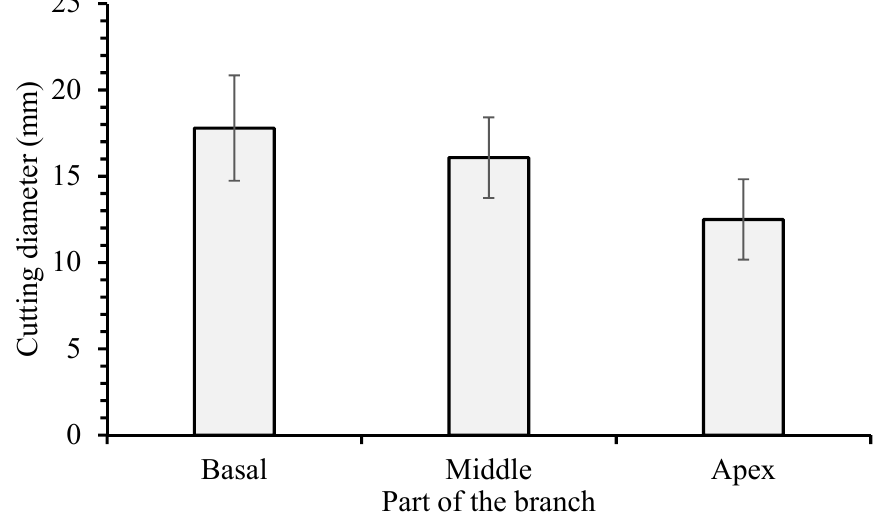
Figure 2. The diameter of Jatropha curcas L. hardwood cuttings at different parts (basal, middle, and apex) of the branch, collected in the upper third of the plant. Values are represented by the mean ± standard deviation of at least three independent replicates.